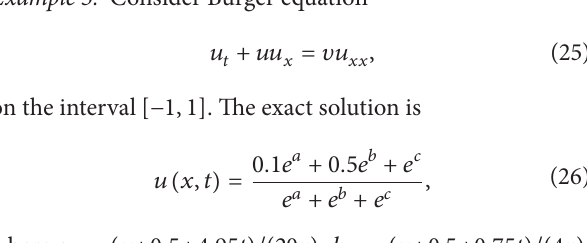
locally bounded adaptive nodes. In Figure 2 the approximate solutions and the central nodes are shown. The values of parameters 𝑘 , 𝛼 and shape parameter 𝑐 , the 𝐿 2 -norms, and 𝐿 ∞ -norms of the approximate solutions are presented in Table 1. Note that the impact of different values of 𝑘 and 𝛼 make some freedom to avoid the ill-conditioning. The values of these parameters which depend on the number of nodes and their distribution form are shown in Table